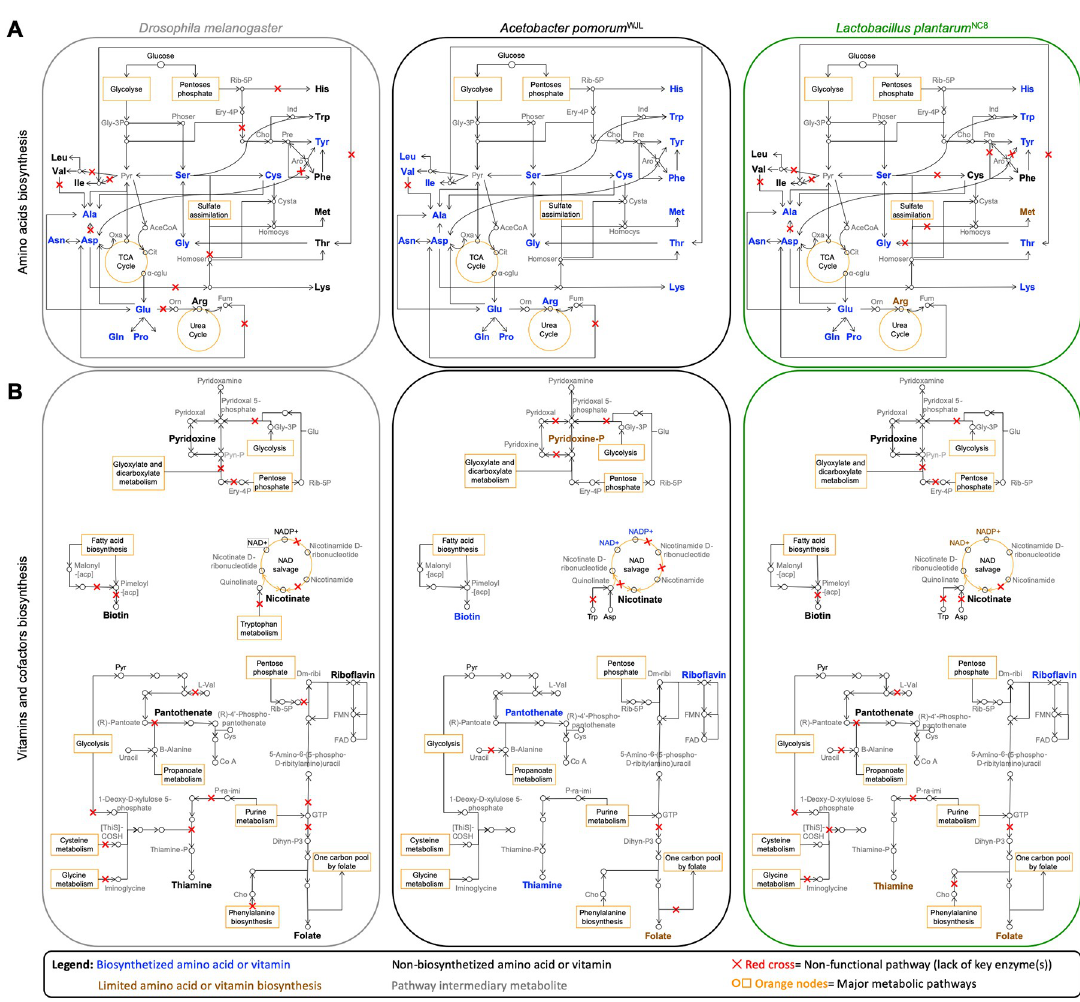
Fig 1. Expert automated genome annotation and metabolic network reconstruction of Drosophila , Ap WJL , and Lp NC8 . (A) Amino acid biosynthetic pathways. (B) Vitamins and cofactors biosynthetic pathways. Left panels, D . melanogaster . Central panels, Ap WJL . Right panels, Lp NC8 . Color code: blue, biosynthesized amino acids or vitamins; brown, limited amino acid or vitamin biosynthesis (biosynthesis of the metabolite may be possible, but it is limited and/or requires secondary metabolic pathways); black, nonbiosynthesized amino acids or vitamins; gray, pathway intermediary metabolites. Red cross: nonfunctional pathway (lack of key enzyme[s]). Orange nods, major metabolic pathways. α -cglu, α -keto-glutarate; AceCoA, Acetyl-CoA; Ant, Antranilate; Ap WJL , A . pomorum WJL ; Aro, Arogenate; Cho, chorismate; Cit, Citrate; Cysta, Cystathionine; Dihyn-P3, 7,8-Dihydroneopterin-3 0 -P3; Dm-ribi, 6,7-Dimethyl-8-ribityllumazine; Ery-4P, Erythrose-4P; FAD, Flavin Adenine Dinucleotide; FMN, Flavin mononucleotide; Fum, Fumarate; Glc, Glucose; Gly-3P, Glycerate-3P; Homocys, Homocysteine; Homoser, Homoserine; Ind, Indole; Lp NC8 , L . plantarum NC8 ; Orn, Ornithine; Oxa, Oxaloacetate; P-ra-imi, 1-(5 0 -Phospho-ribosyl)-5-aminoimidazole; Phoser, Phosphoserine; Pre, Prephenate; Pyn- P, Pyridoxine phosphate; Pyr, Pyruvate; Rib-5P, Ribose-5P; TCA, Tricarboxylic acid Cycle; [ThiS]-COSH, [ThiS]-thiocarboxylate.